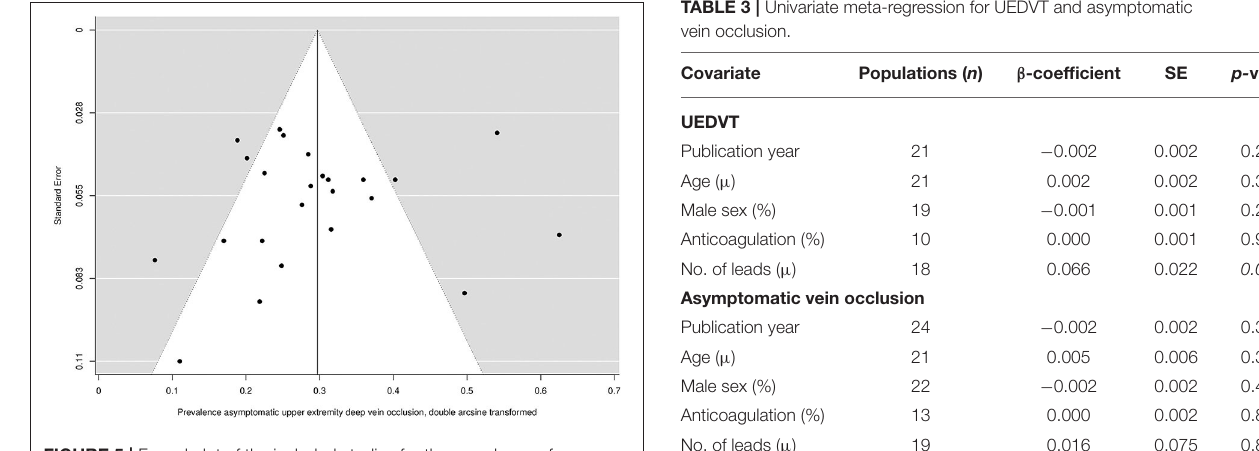
FIGURE 5 | Funnel plot of the included studies for the prevalence of asymptomatic vein occlusion.